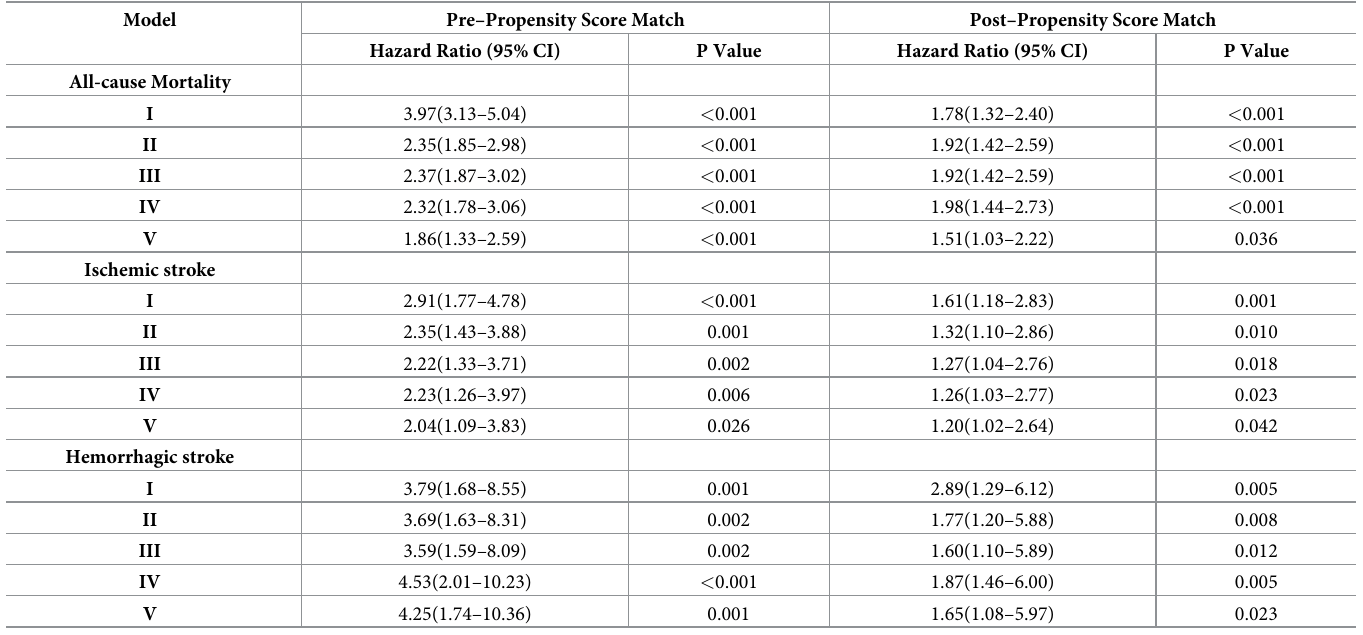
Table 2. Cox proportional hazards analyses of mortality and stroke events among participants with AF before and after propensity score matching.